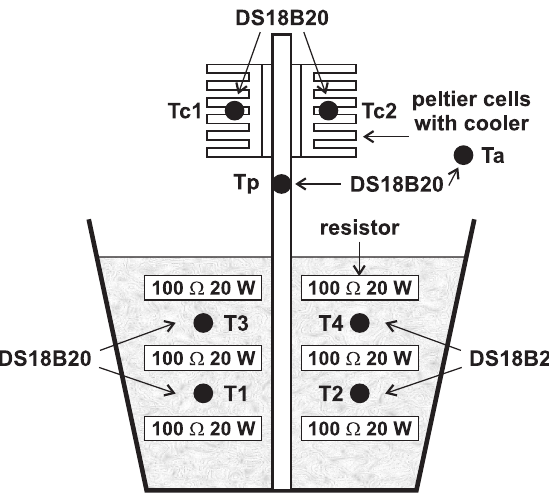
Figure 7. Layout of experimental setup for simulation of real conditions.